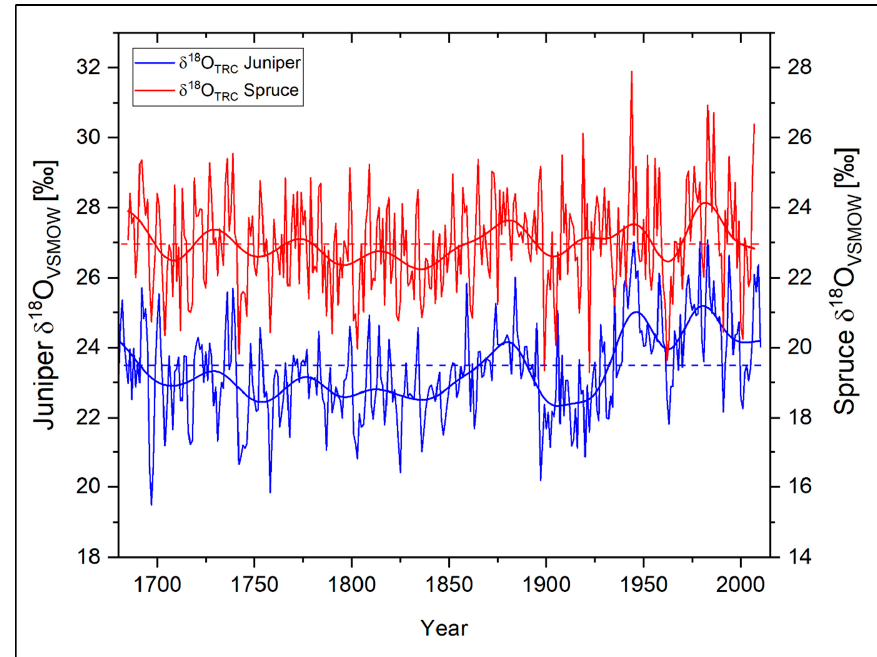
Figure 3. Annual δ 18 O TRC variations of Juniperus tibetica (blue) and Picea balfouriana (red) at Qamdo for the period 1685 − 2010. Bold lines represent the respective 11-year Fast Fourier Transform (FFT) filter for each time-series, dotted horizontal lines the individual species mean. Note: Individual y-axes are shifted against each other with an offset of 4 ‰ to better show the high synchronicity between both